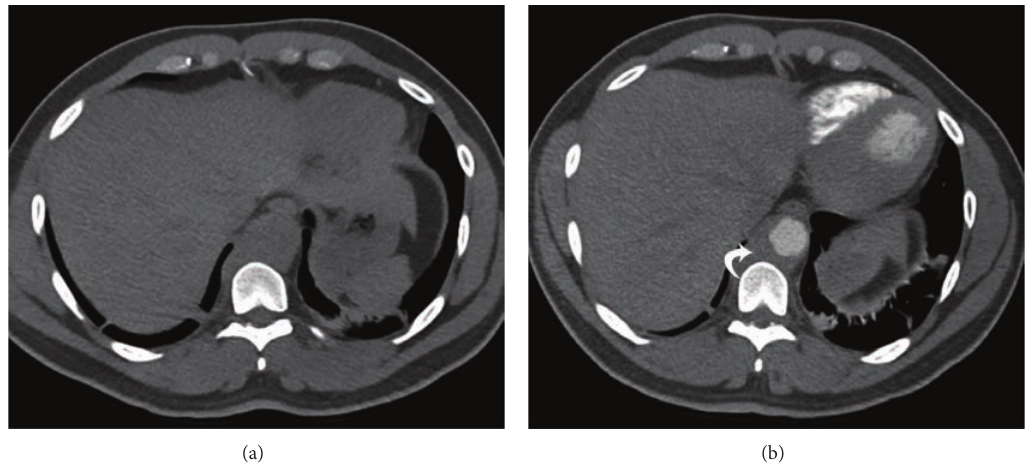
Figure 16: Contained rupture—(a) noncontrast CT scan in a patient presenting with acute chest pain shows nonspecific soft tissue adjacent to descending thoracic aorta. (b) Contrast enhanced CT at the same level shows lack of distinction between the posterior wall of the aorta and the adjacent vertebral body, the “draped aorta” sign (curved arrow), which is indicative of a contained rupture.